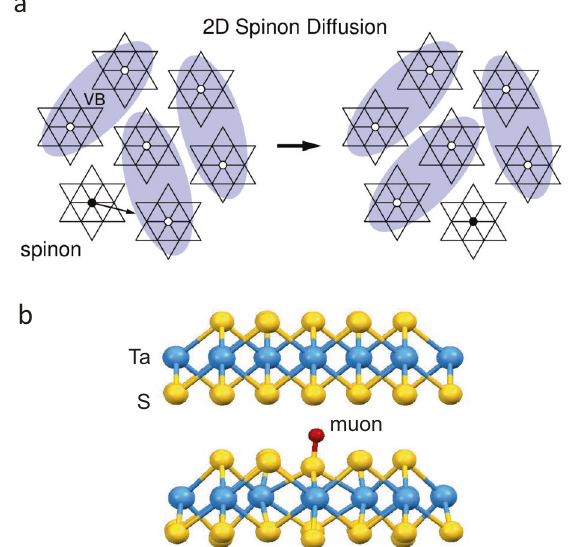
Fig. 1 Excitations in 1T-TaS 2 and the muon probe site. a The basic hopping step for 2D spinon diffusion in a QSL involves rearrange- ment of the valence bonds (VB). b A typical interstitial muon probe site obtained using